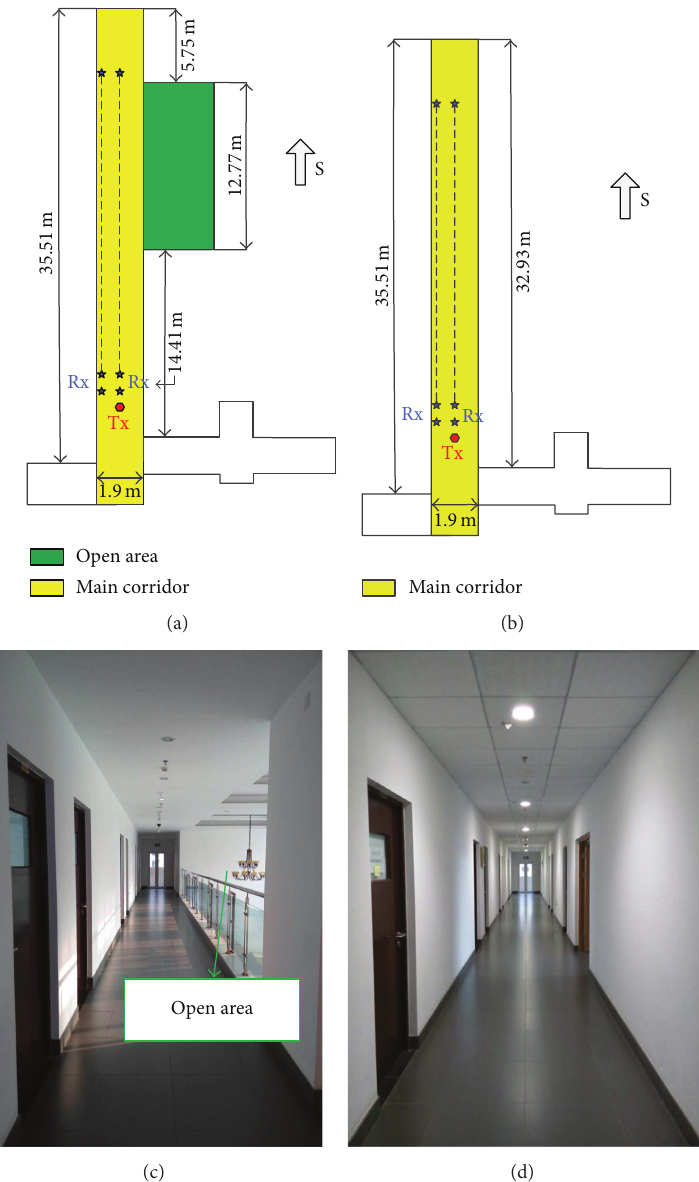
Figure 1: (a) Diagram of floor 2 in Mechanical Engineering Building. (b) Diagram of floor 4 in Mechanical Engineering Building. (c) Photograph of measurement scenario on floor 2. (d) Photograph of measurement scenario on floor